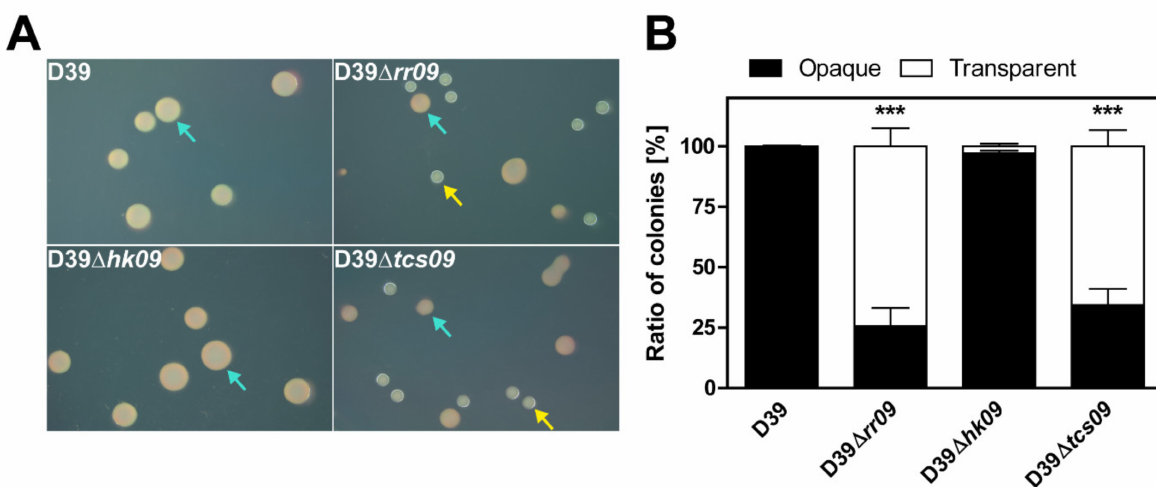
Figure 6. Colony morphology of opaque (O) and transparent (T) variants of S. pneumoniae D39 and isogenic tcs09 -mutants. ( A ) Transparent (yellow arrow) and opaque (turquoise arrow) colonies of D39 and isogenic mutants plated on tryptic soy agar supplemented with catalase. ( B ) Percentage distribution of O and T colonies in D39 and isogenic mutants. Images were taken under oblique transmitted illumination using a Leica M125 C dissecting microscope and LAS X software. Results are presented as the mean ± SD for three independent experiments. An independent student’s t -test proved a significance with p -value *** < 0.001 relative to the parental pneumococcal strain